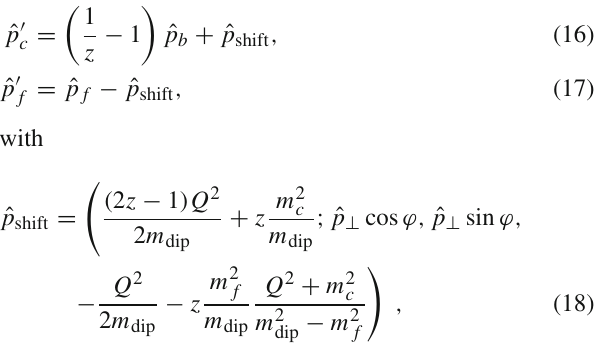
= ( p + p ) 2 . Note that the dipole mass is not with m 2 b f dip conserved during the branching. After the